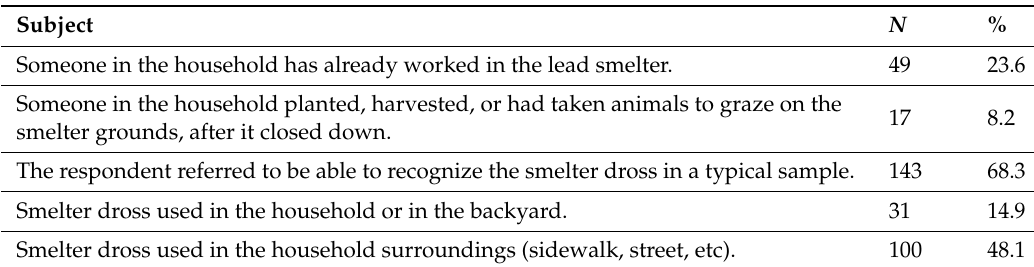
Table 1. The occupational relationship with the lead smelter and with the smelter dross reported by residents in 208 households from Santo Amaro City, 2008.